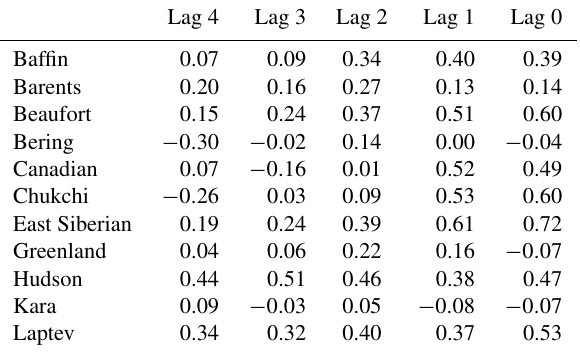
Table 4. The correlation coefficients between the detrended pan- Arctic September sea ice extent and the regional September sea ice extent. A detailed description regarding the definition of each region is given here: ftp://sidads.colorado.edu/DATASETS/NOAA/ G02135/seaice_analysis/ (last access: 10 May